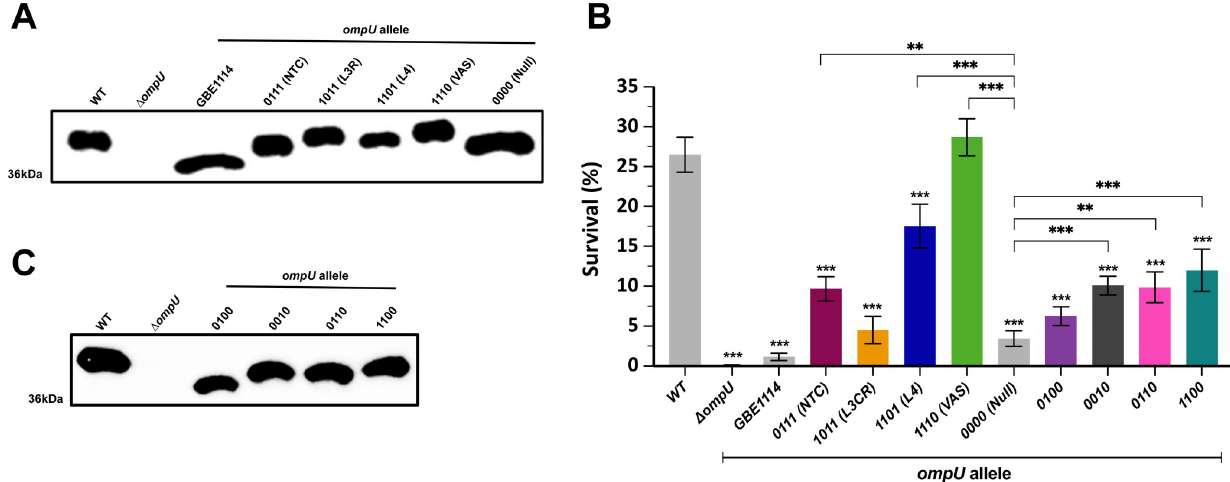
Fig 3. OmpU domain mutants exhibit differential resistance to 0.4% bile. (A) Immunoblot analysis of individual OmpU domain mutants. (B) Survival of individual and naturally occurring ompU domain combination mutants in the presence of 0.4% whole bile. (C) Immunoblot analysis of naturally occurring OmpU domain mutants. Error bars represent the standard deviation of the mean from at least three ( N � 3) independent replicates. Statistical comparisons were performed using one-way ANOVA analyses followed by a Dunnett’s multiple comparison test. All constructs were compared to the WT unless otherwise stated. * p < 0.05, ** p < 0.01, *** p < 0.001.